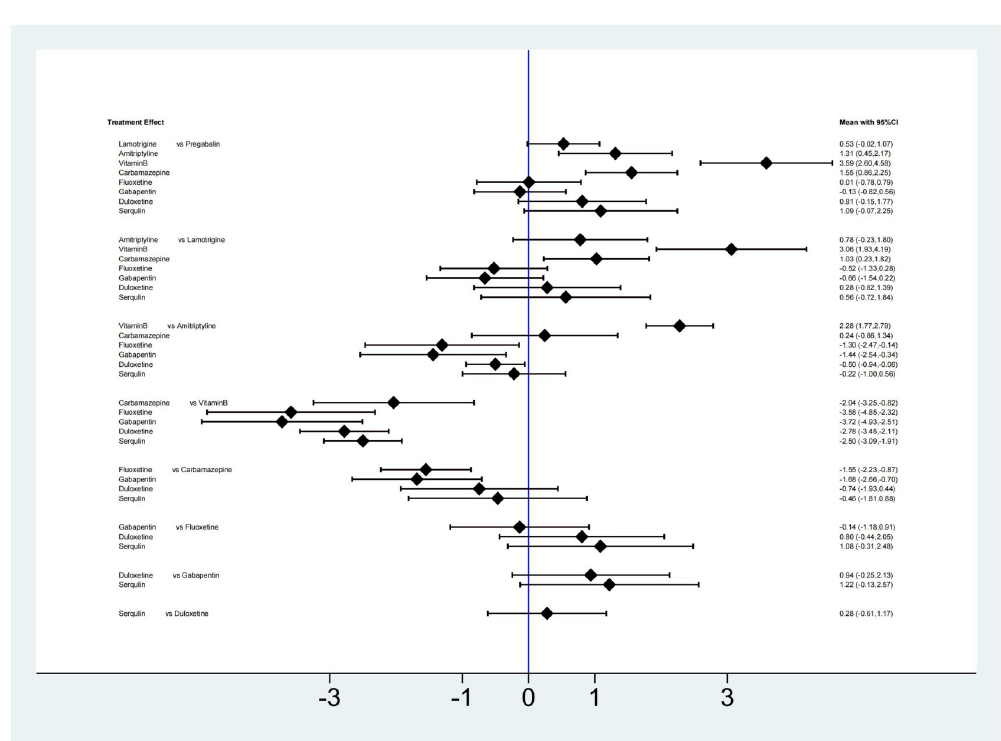
Fig 4. Network meta-analysis of VAS